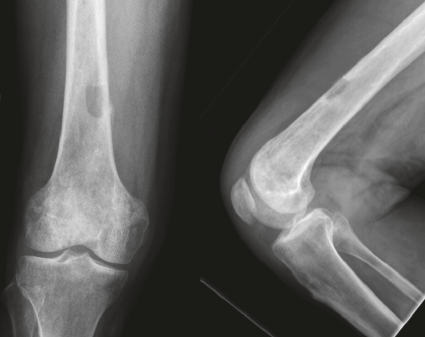
Figure 1: AP and lateral right knee with distal femur sequestrum/ involucrum and small periosteal reaction.